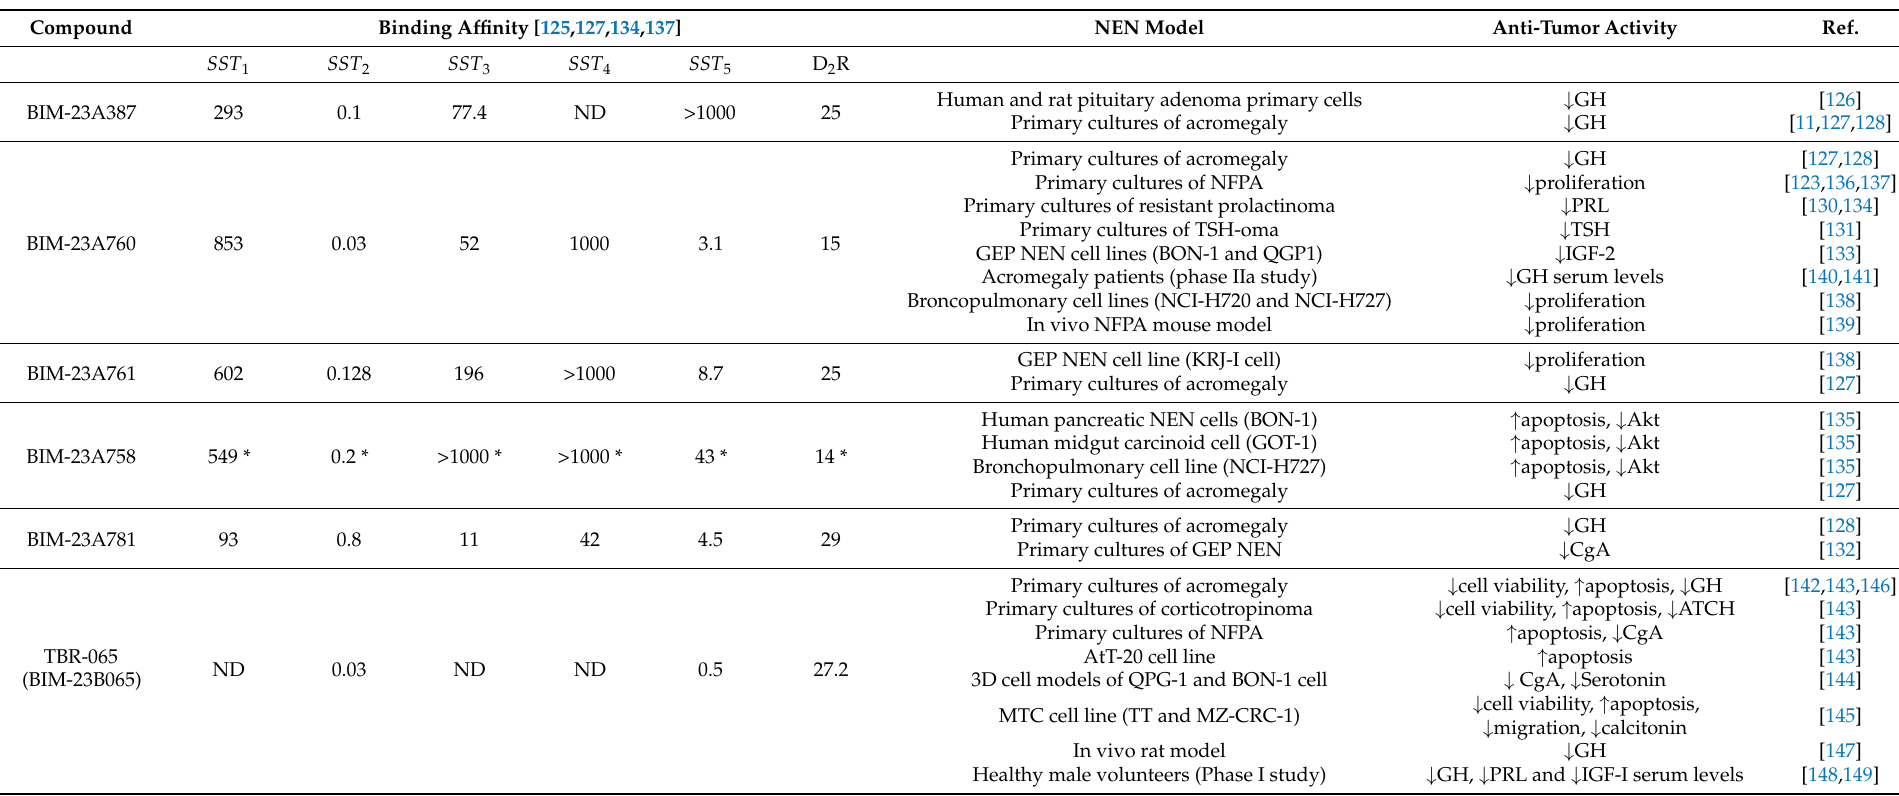
Table 1. Comprehensive overview of somatostatin-dopamine chimeric compounds, their receptor binding affinity and antitumor activity in NENs. Human SST s and D 2 R binding affinities are expressed in IC50 in nM, binding affinities marked with * are expressed with Ki (dissociation constant (nM)). ND: Not detected.